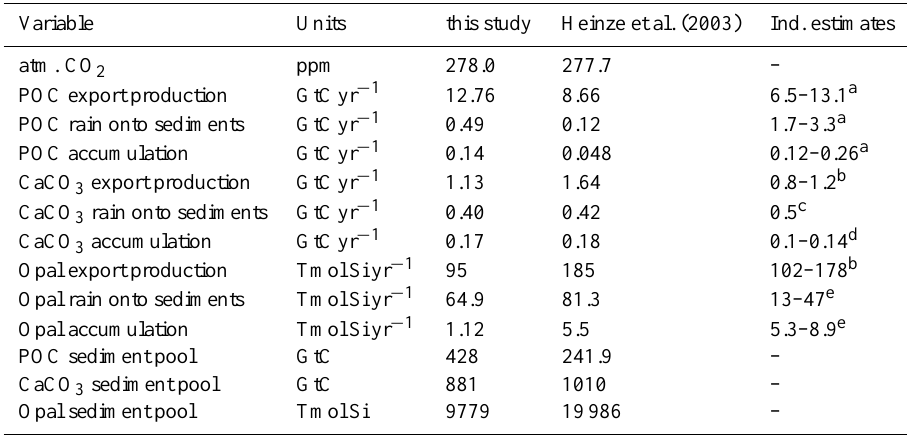
Table 1. Bulk numbers characterising the preindustrial steady state of the coupled ocean-sediment Bern3D+C model compared to previous modelling results and independent